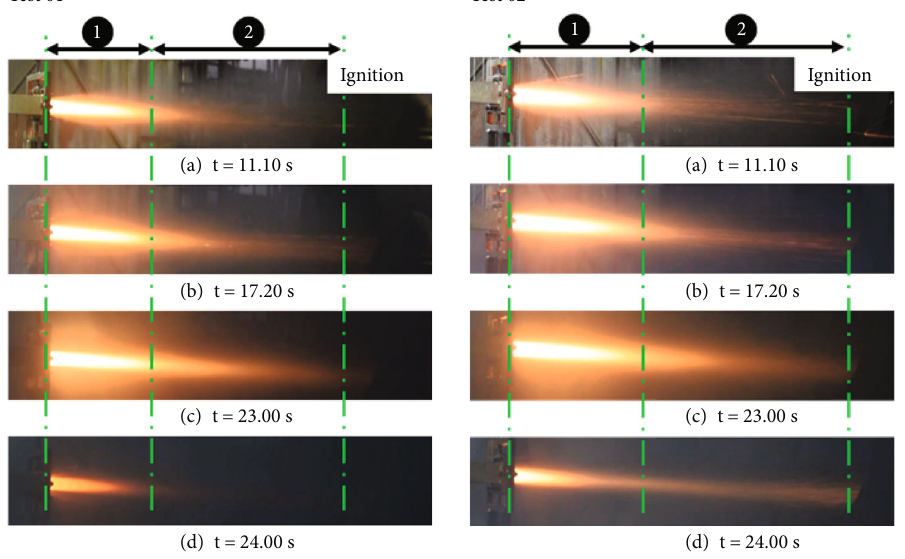
Figure 9: Solid scramjet exhaust